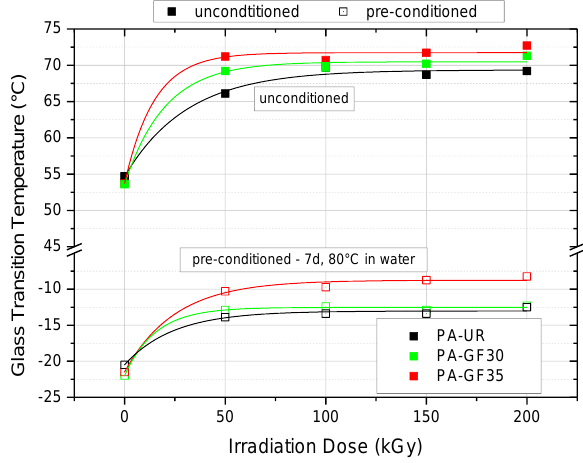
Figure 7. Glass transition temperatures for the three PA grades depicting the effect of water absorption and irradiation dose.